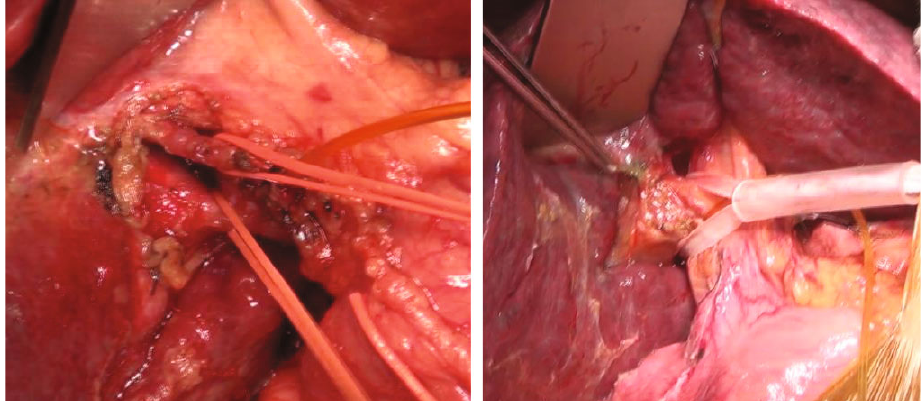
Figure 3: Intrafascial and extrafascial right pedicle approach.